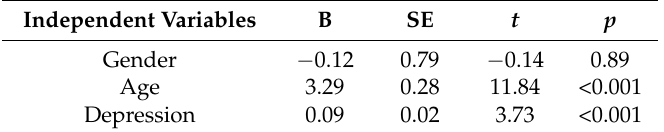
Table 6. The effect of age, gender and depression as predictors of obvious decay